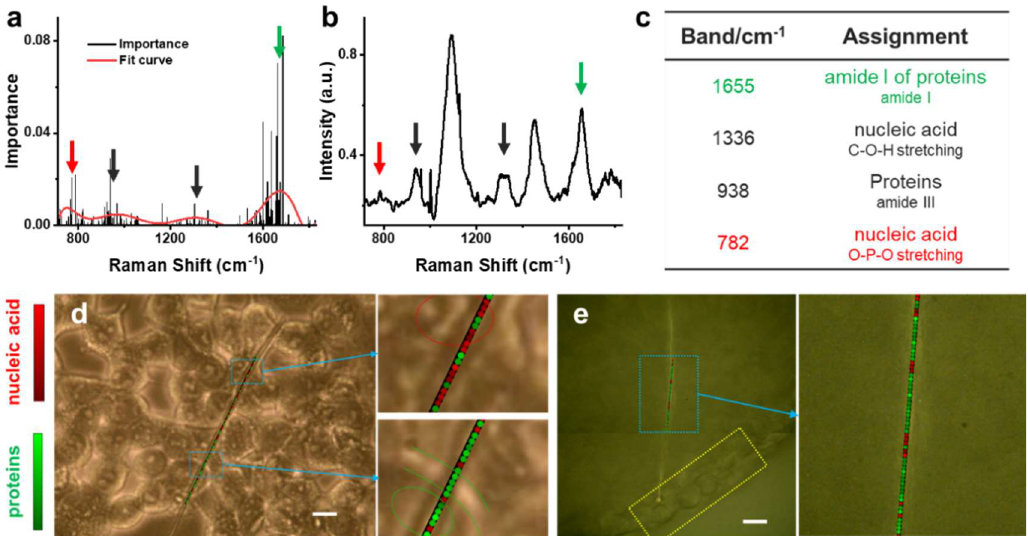
Figure 4. ( a ) Importance of Raman shift learned from 803 SERS spectra of 2D model using Random Forest algorithm. The red curve represents the fit curve of the importance. Arrows point out four important Raman bands. The red and green arrows point out the two most important bands, respectively. ( b ) Average spectrum of all the 803 SERS spectra obtained from 2D model. Arrows point out the four corresponding bands in ( a ). ( c ) Raman shifts and tentative assignments of the important Raman bands found by Random Forest. ( d ) Distribution of proteins and nucleic acids in 2D model using K-means++ algorithm. In the upper panel, the red circle indicates cell nucleus. In the bottom panel, the green circle indicates cytoplasm while the area between two green curves indicates the area of ECM. ( e ) Distribution of proteins and nucleic acids in 3D model using K-means++ algorithm. The optical microscope shows the morphology of outer layer cells (yellow rectangle) in 3D model. The inset (blue rectangle) represents the protein-rich regions and nucleic acid-rich regions in 3D model after the spectral data were analyzed by the machine learning algorithm. Scale bars in ( d ) and ( e ) 20 μm.